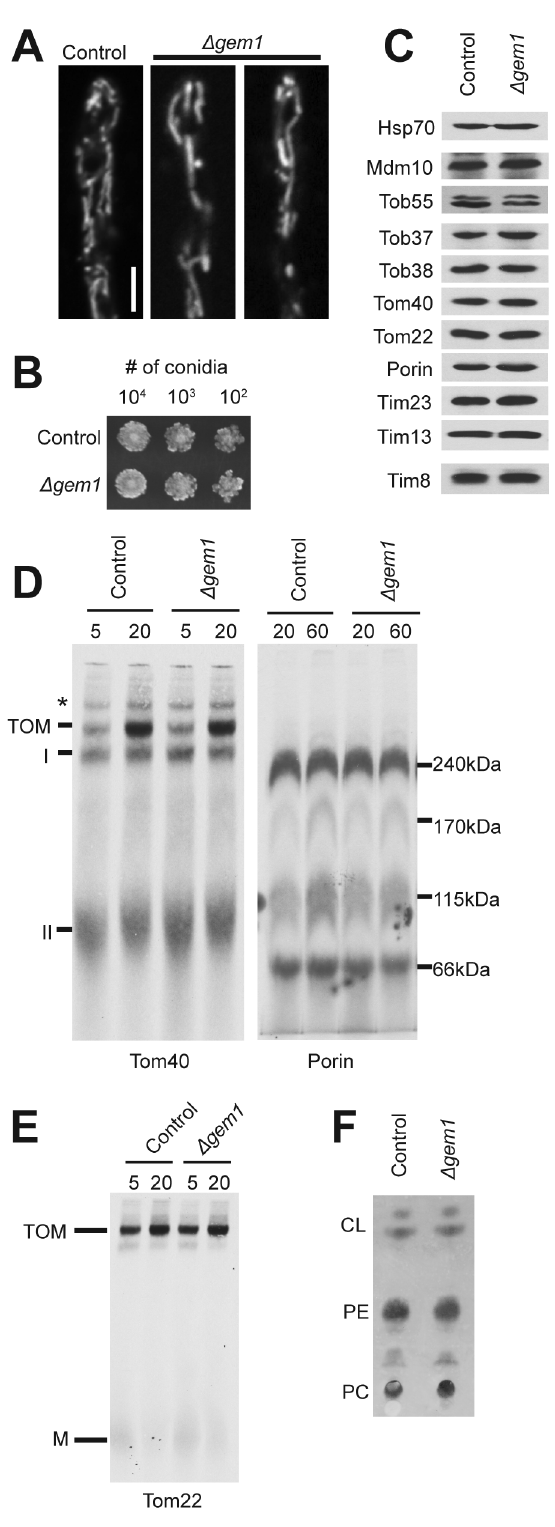
Figure 7. Characterization of the D gem1 strain. A. Examination of mitochondrial morphology as in Figure 3D. B. Growth rates as in Figure 3C. C. Steady state levels of mitochondrial proteins as in Figure 5A. D. b - barrel protein (Tom40 and porin) assembly as in Figure 4A and B, respectively. E. Tom22 assembly as in Figure 4C. F. Mitochondrial phospholipid content as in Figure